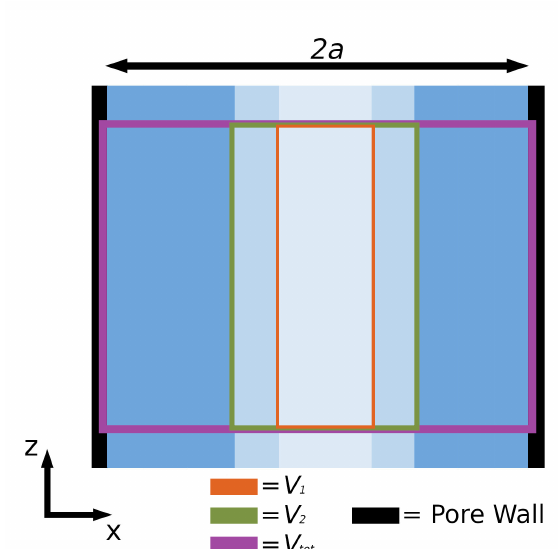
Figure 3. The core layer of the slit pore (lightest color) and subsequent layers (progressively darker color) used in the calculation of the pressure tensor of the fluid. V 1 and V 2 are the volumes of the core and the core plus one layer, respectively. V tot is the total volume, covering all interactions with the pore